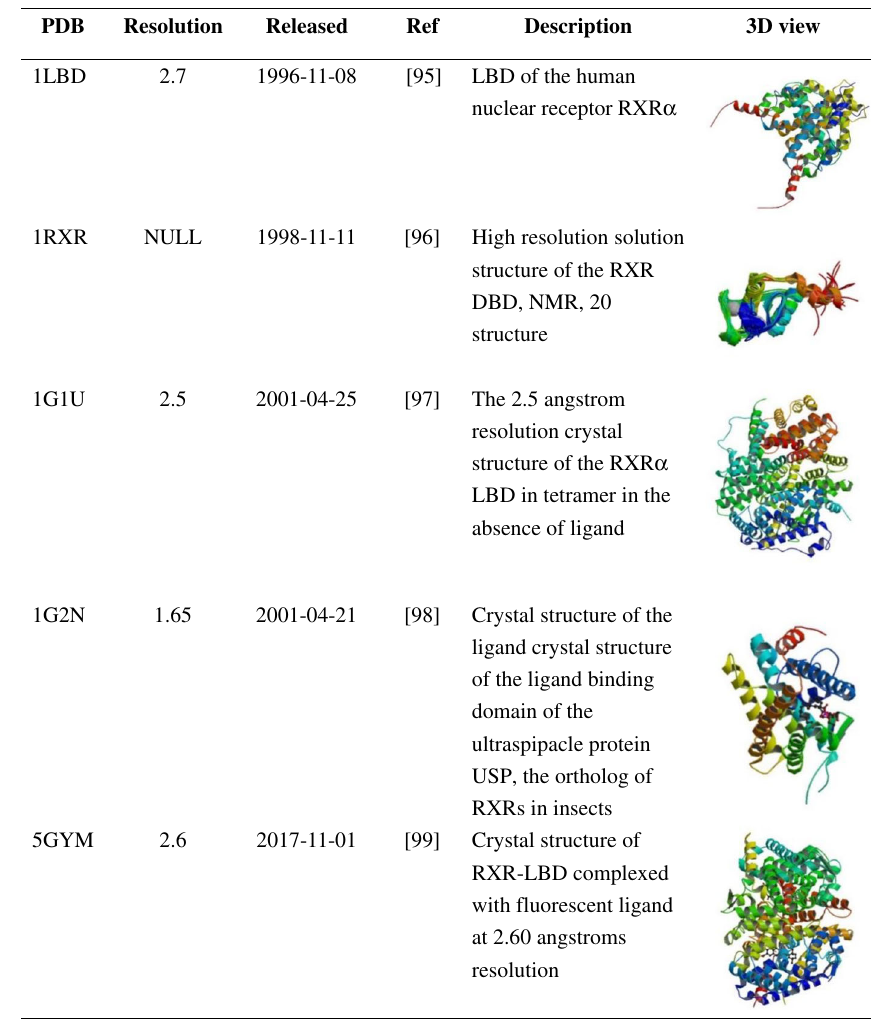
Table 4 The 3D structure of RXR α [95 – 99]